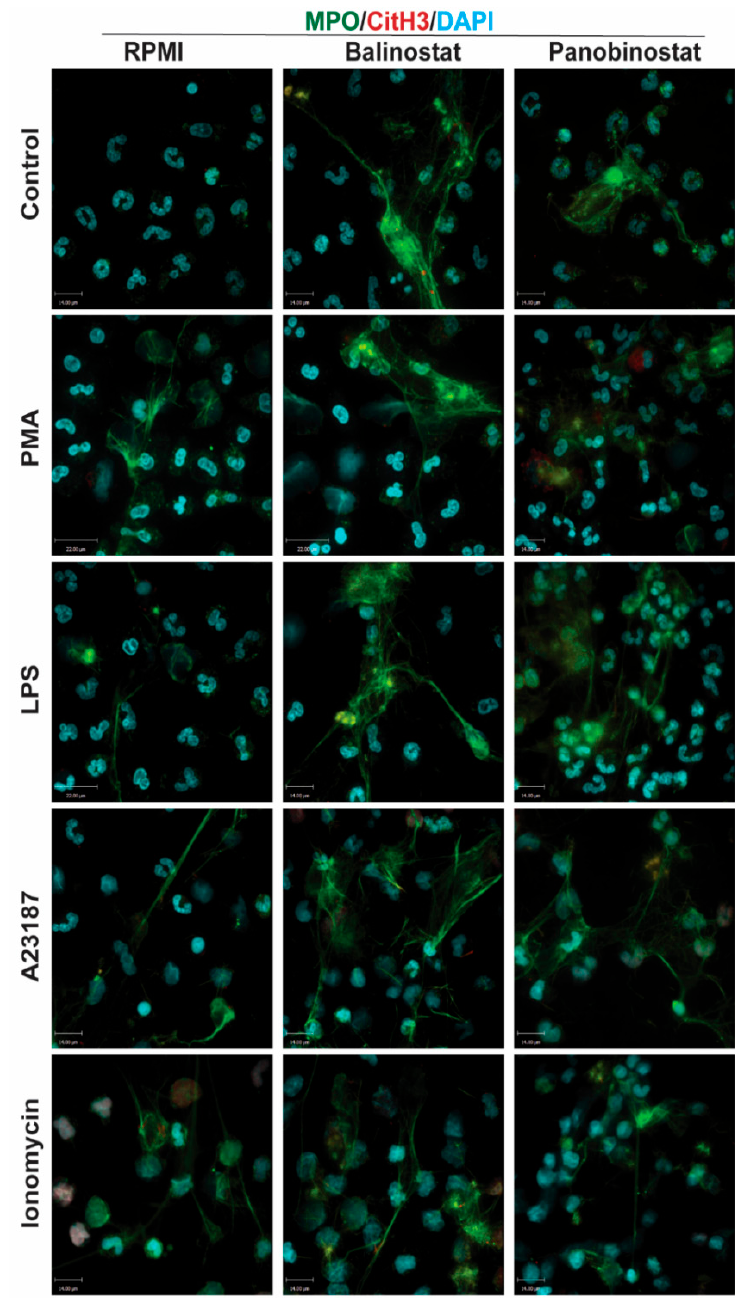
Figure 4. Confocal microscopy images confirm that HDACis promote baseline NETosis, as well as NOX-dependent and -independent NETosis. Neutrophils were treated with negative control (RPMI), or NETotic agonists (25 nM PMA; 4 μ M A23187; 5 μ g/mL LPS from E. coli 0128; 5 μ M Ionomycin) for 120 min. Then, cells were fixed, immunostained, and imaged for myeloperoxidase (MPO), citrullinated histone H3 (CitH3) and DNA (DAPI). Cells in RMPI media show typical polymorphonuclear morphology of neutrophils where myeloperoxidase (MPO) can be observed in the cytoplasm. In neutrophils treated with PMA and LPS, MPO co-localizes to NET DNA; limited amounts of CitH3 can be observed. However, CitH3 increases drastically when neutrophils are treated with either A23187 or ionomycin. Interestingly, neutrophils treated with HDACis have increased levels of NETosis in all conditions, which is evident by the intense co-localization of MPO and DNA. Blue: DAPI staining for DNA; Green: MPO; Red: CitH3. Scale bar, 14 μ m. n = 2–3.